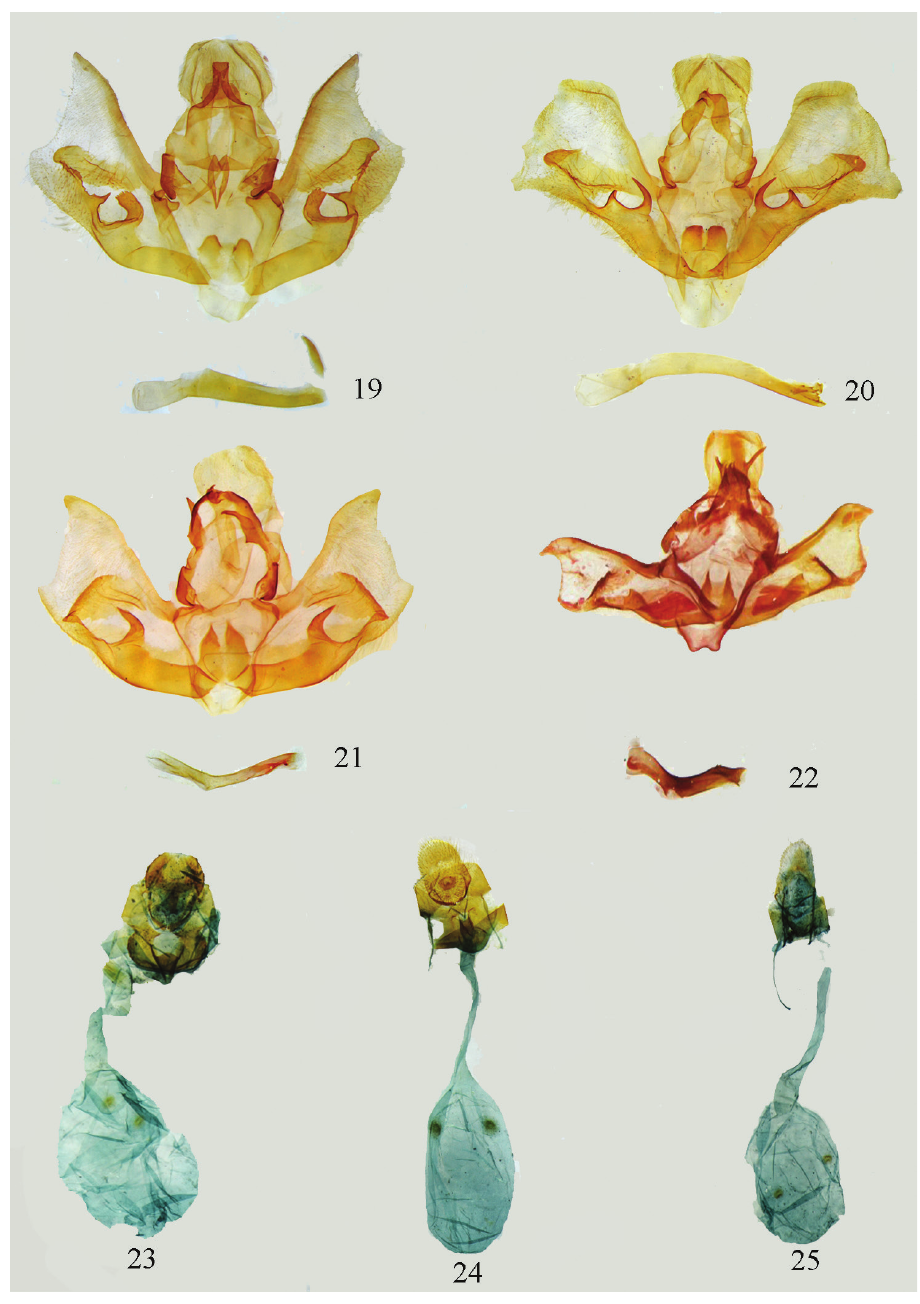
Figures 19–22. Male genitalia. 19 Lista menghaiensis sp. n., holotype, gen. slide no. Ep539 20 L. plinthochroa (West, 1931), gen. slide no. Ep543 21 L .sichuanensis sp. n., paratype, gen. slide no. Ep521 22 L. variegata (Moore, 1888), gen. slide no.